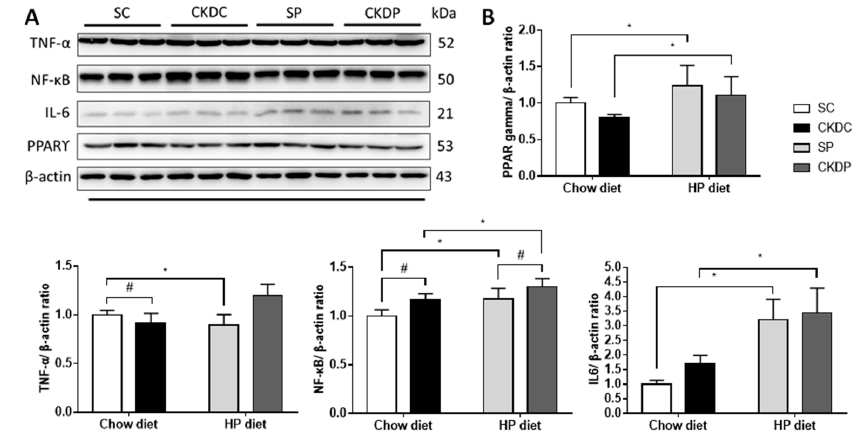
Figure 7. Protein expressions of testicular inflammation pathway markers in high phosphorus diet-fed mice with or without CKD induction. ( A ) Protein expressions of inflammation pathway markers (TNF- α , NF- κ B, IL-6 and PPAR γ ) and β -actin was used for normalization; ( B ) relative density analysis of the protein bands. Data are expressed as the mean ± SD. # indicates a significant difference between the sham-operated and CKD-induced groups (SC vs. CKDC and SP vs. CKDP); * indicates a significant di ff erence between the chow diet and high phosphorus diet groups (SC vs. SP and CKDC vs.